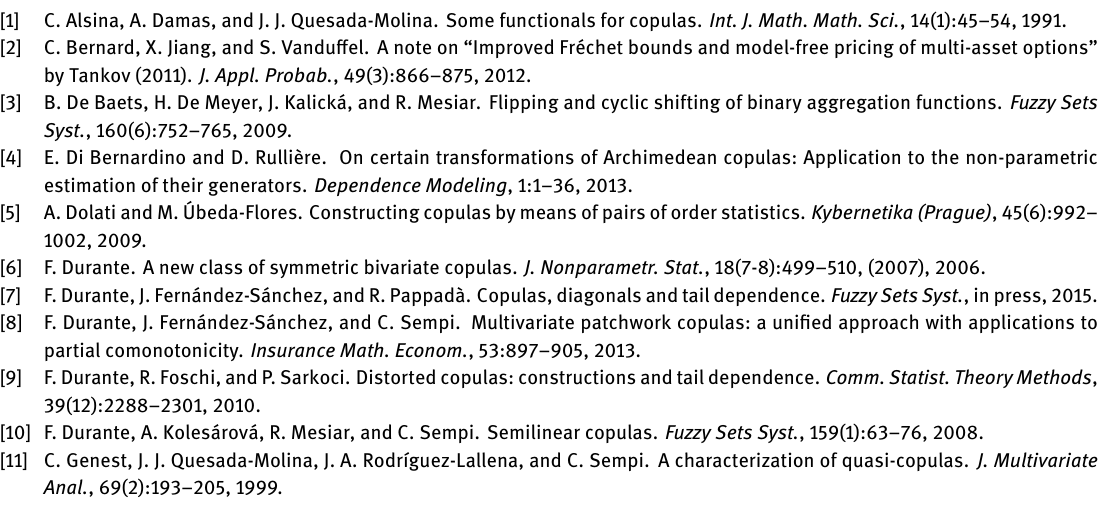
( W ) for n ∈ { 0, 1, 5, 20 } , whereby λ = 1/2 λ